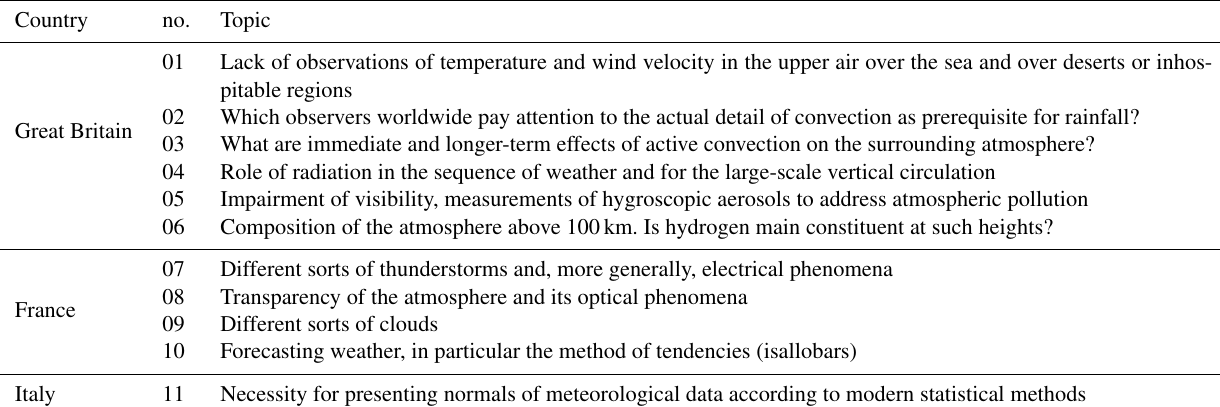
Table 1. Numbered topics (“gaps in our knowledge”) outside of the routine investigations of meteorological services, suggested by three National Committees of IAM for discussion at the general assembly of 1922 in Rome (Shaw, 1923). Country